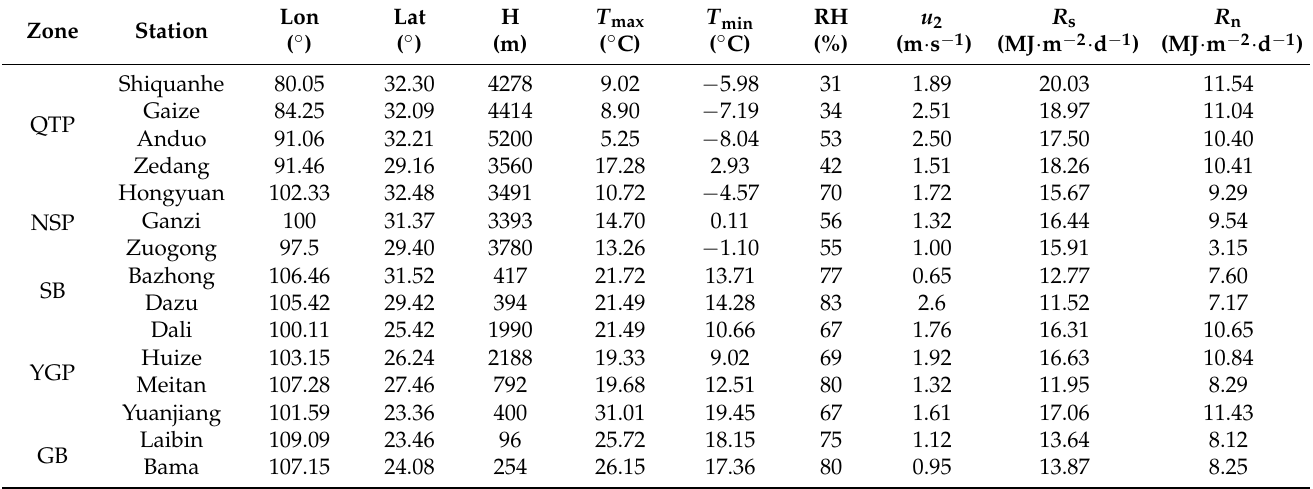
Table 1. Annual means of the main meteorological parameters at each station during 1992 – 2016.